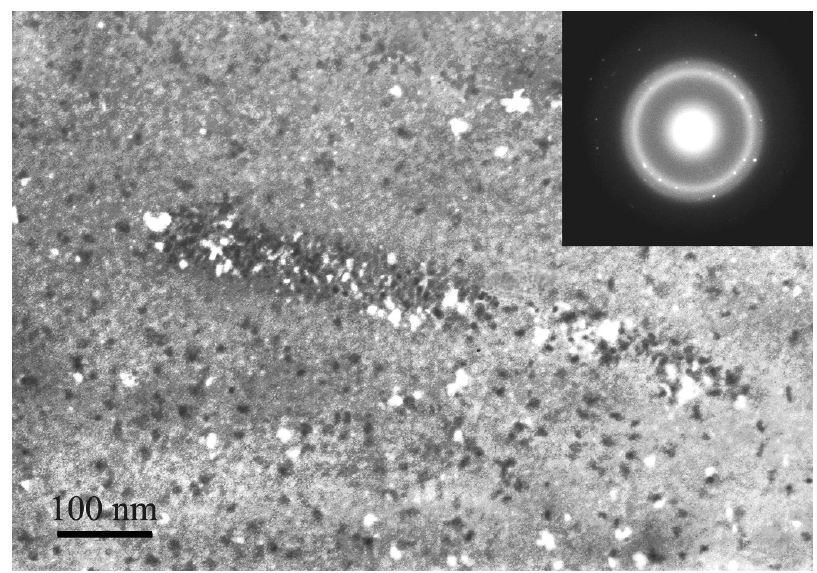
Figure 15. Microstructure of a sample after rolling and heating to 245 ◦ C [reproduced from Physics of The Solid State 2011, 53, 229 with permission from Pleiadis Publishing, 2020] [89].